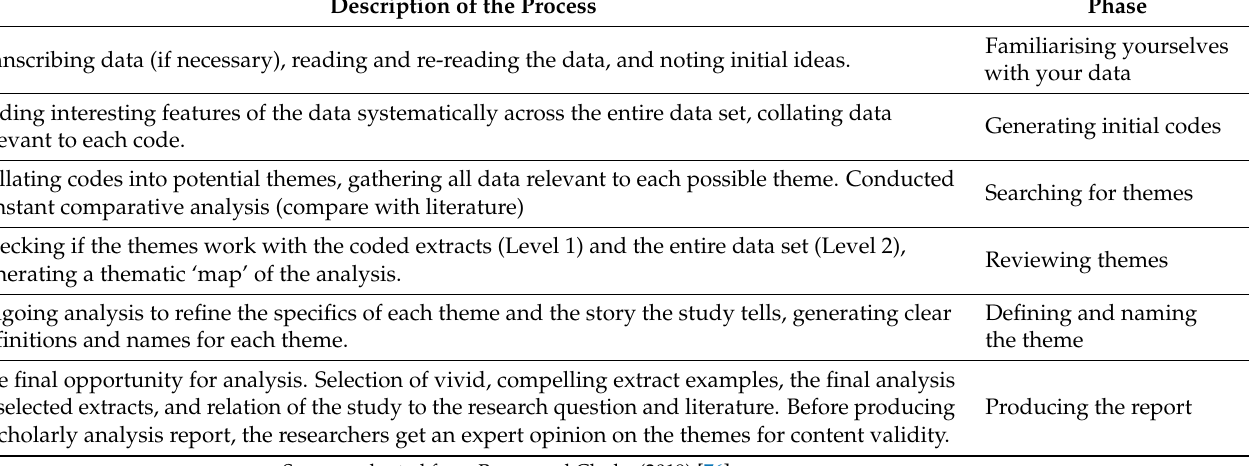
Table 4. Phases of thematic